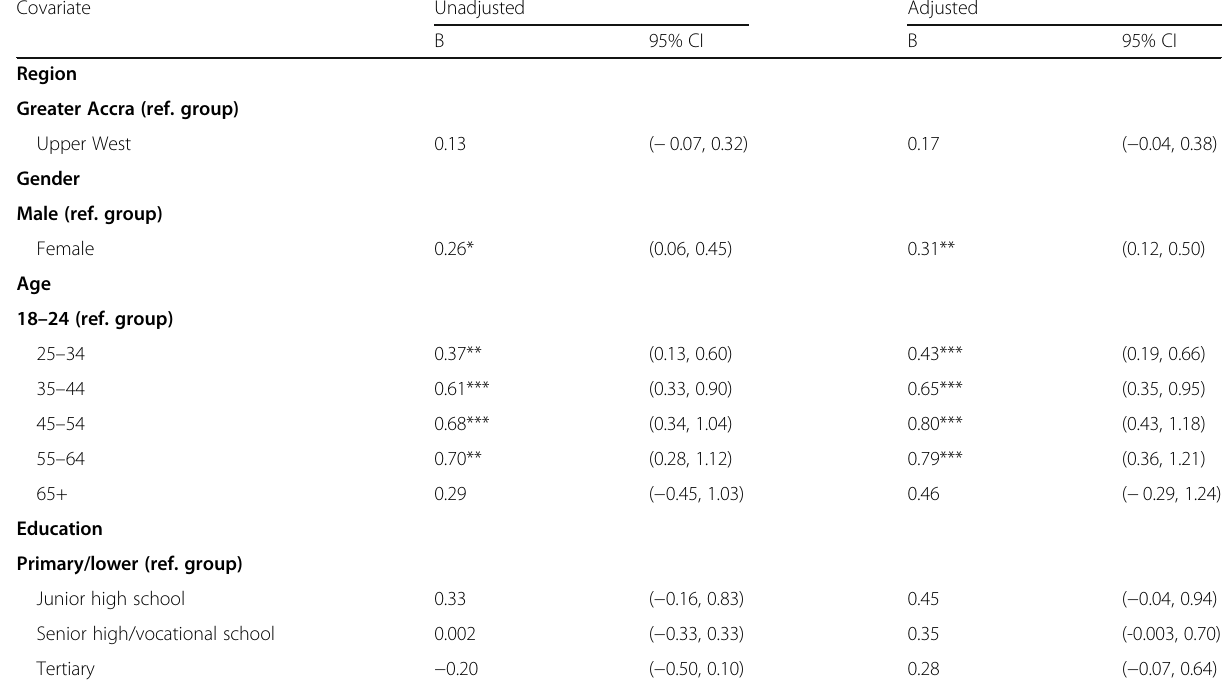
Table 2 OLS results for Knowledge (n = 400) Covariate Unadjusted